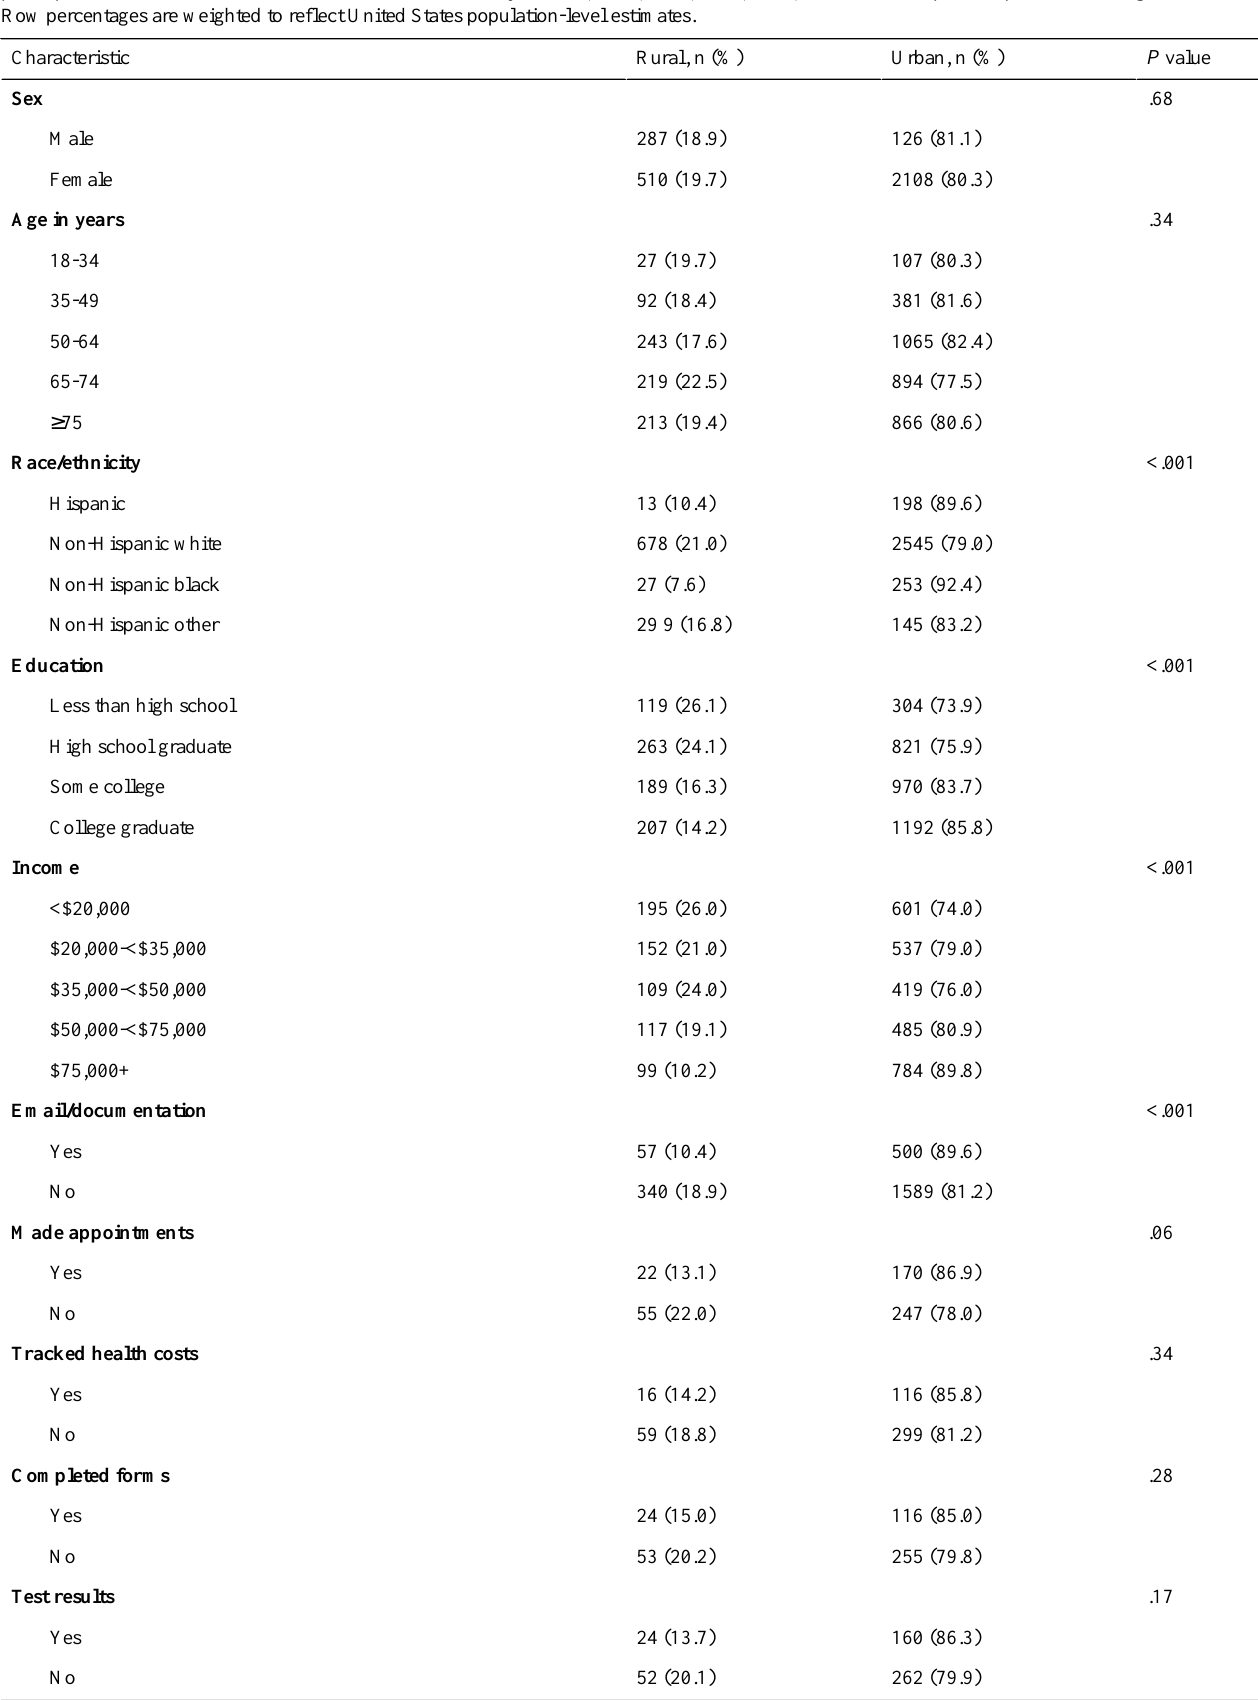
Table 1. Association between urban/rural status, sociodemographic characteristics, and health information technology use among cancer patients who participated in the Health Information National Trends Survey in 2003, 2005, 2008, 2011, 2013, and 2017 and reported a prior cancer diagnosis (n=4163). Row percentages are weighted to reflect United States population-level